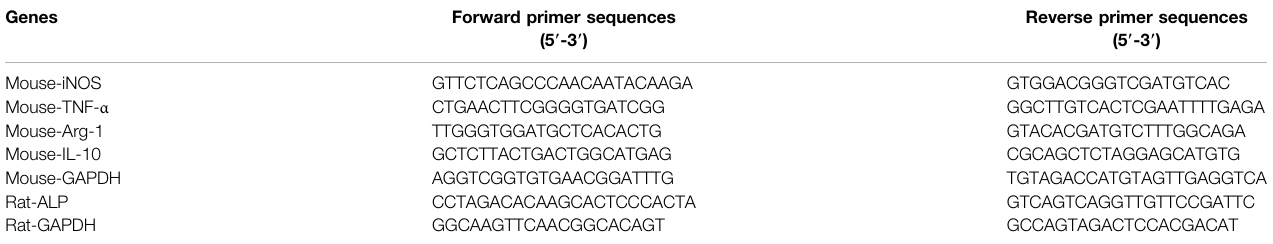
TABLE 1 | Primer sequences of